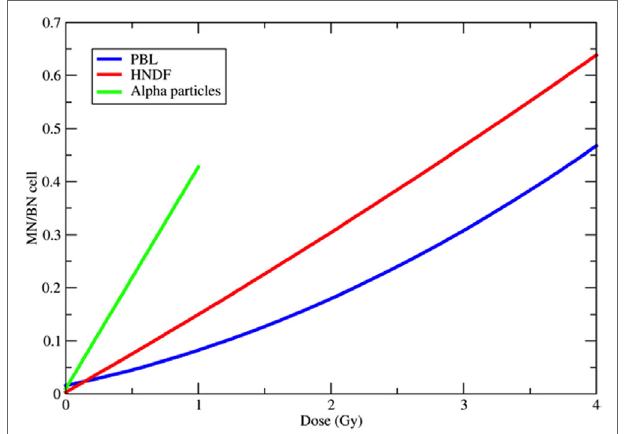
FiGURe 3 | Examples of dose-response curves for the induction of micronuclei (MN) per binucleated (BN) cell. The blue curve is the weighted mean of the calibration curves used in 10 different European laboratories for MN biodosimetry using human peripheral blood lymphocytes (PBL) within the RENEB project (78). The equation is Y = 0.016 + 0.0508· D + 0.0155· D 2 , where Y is the frequency of MN per BN cell and D the 60 Co γ -ray dose in gray. The red curve refers to human neonatal dermal fibroblasts (HNDF) exposed to 60 Co γ -ray (59). The equation used by the authors to fit their data was Y = 0.033 + 0.1423· D + 0.0041· D 2 . The green line refers to human PBL exposed to 239 Pu α -particles (61). Data points (all at doses < 1 Gy) were fitted by the function Y = 0.098 + 0.418· D